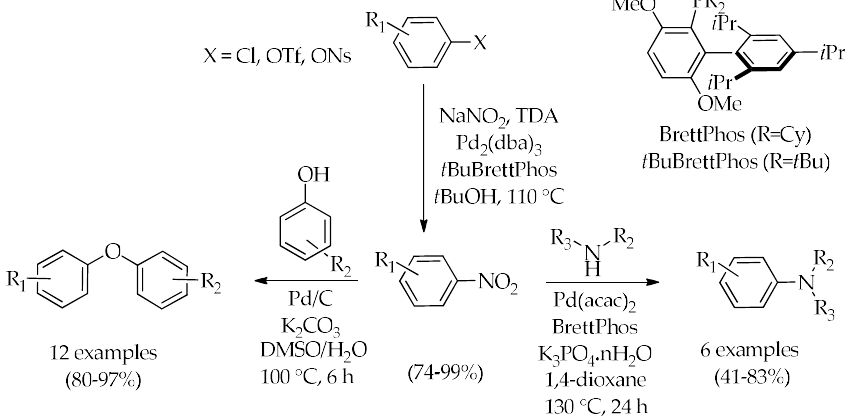
Scheme 2. Pd-catalyzed conversion of aryl chlorides, triflates, and nonaflates into nitroarenes [23],